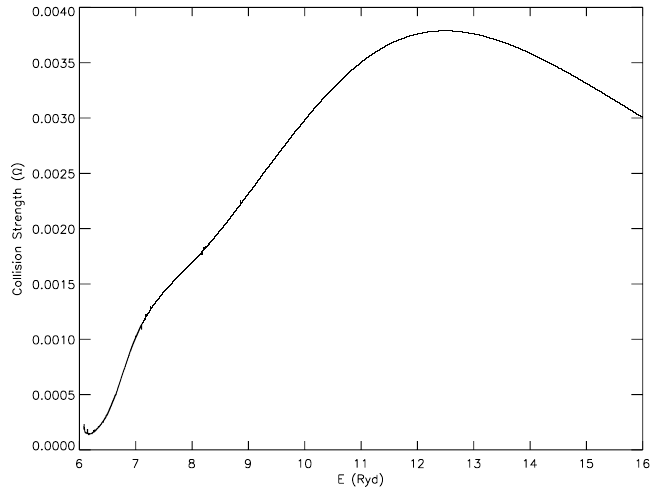
Figure 5. Collision strengths for the 30–235 (2s4s 1 S 0 –2p7d 3 P o calculations of